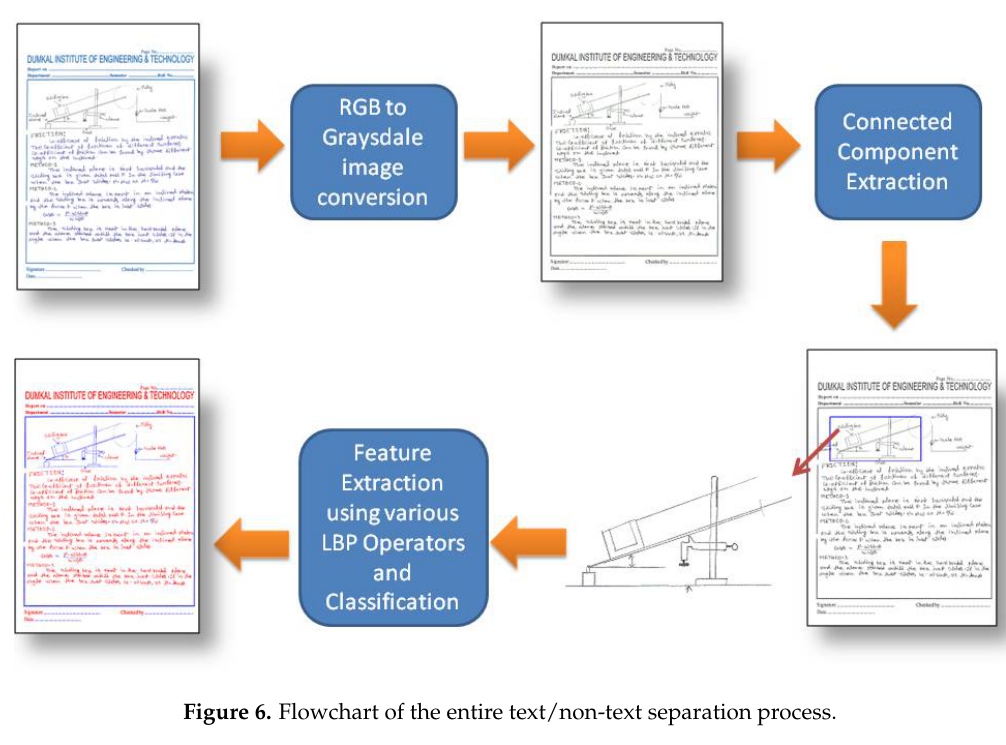
Figure 6. Flowchart of the entire text/non-text separation